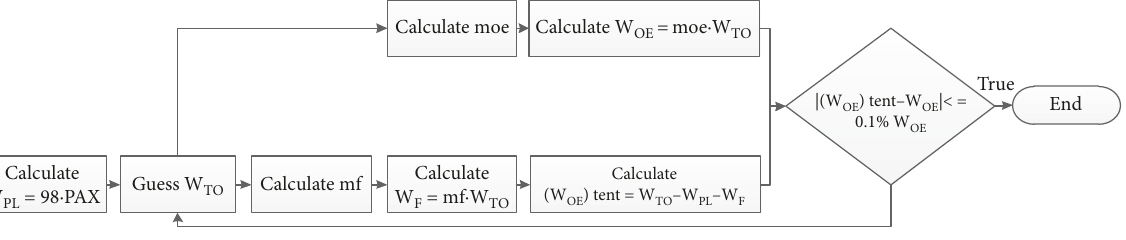
Figure 6: Aircraft preliminary weight estimation fl ow chart.